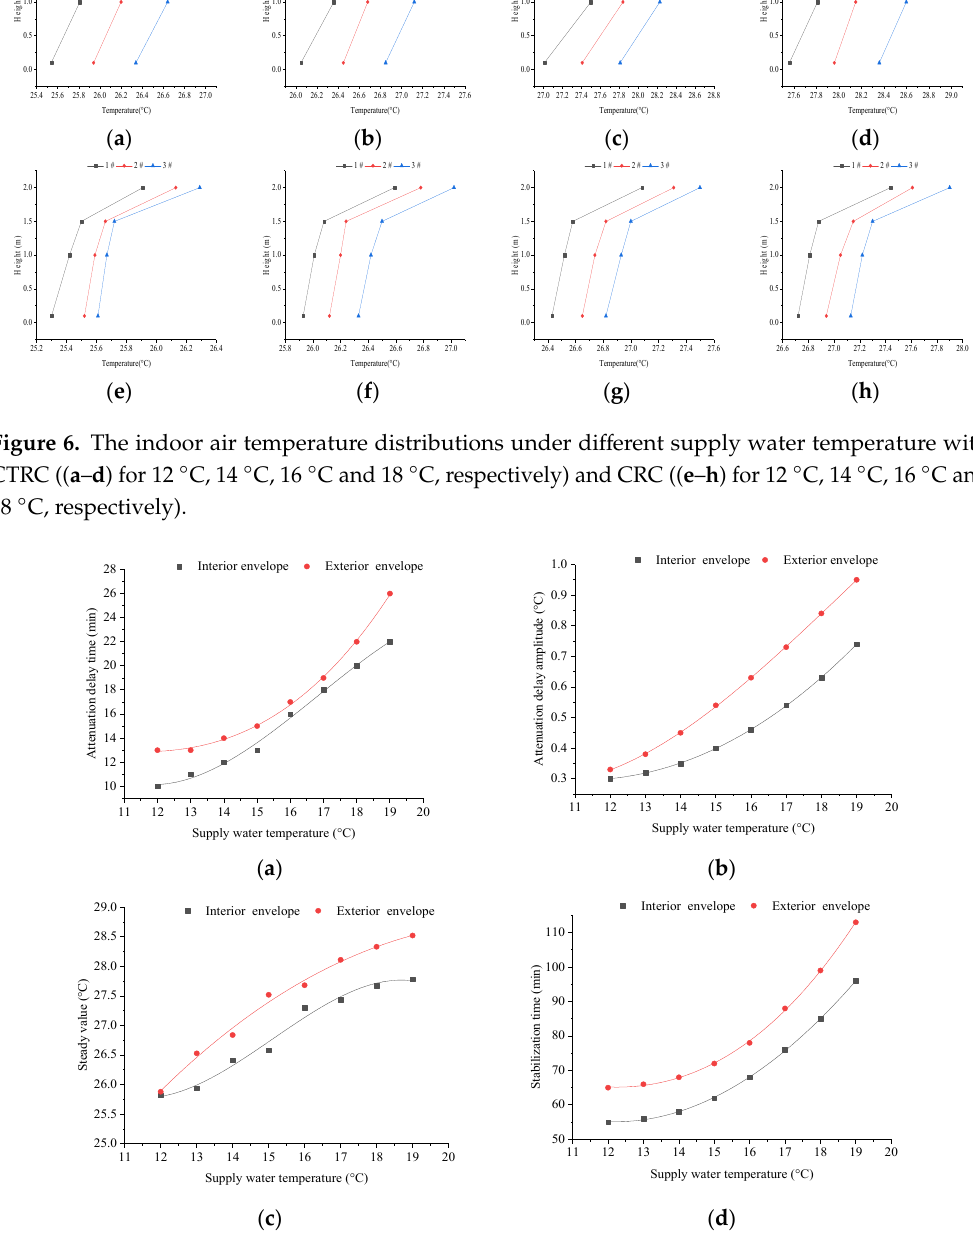
Figure 7. Change in stabilization time ( a ), steady value ( b ), attenuation delay time ( c ) and attenuation delay amplitude ( d ) of the envelope with supply water temperature for the CTRC system.